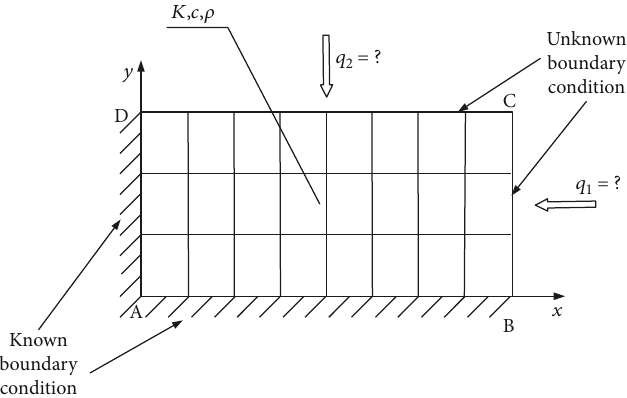
Figure 3: The model of a rectangular cross-section of an in fi nitely long